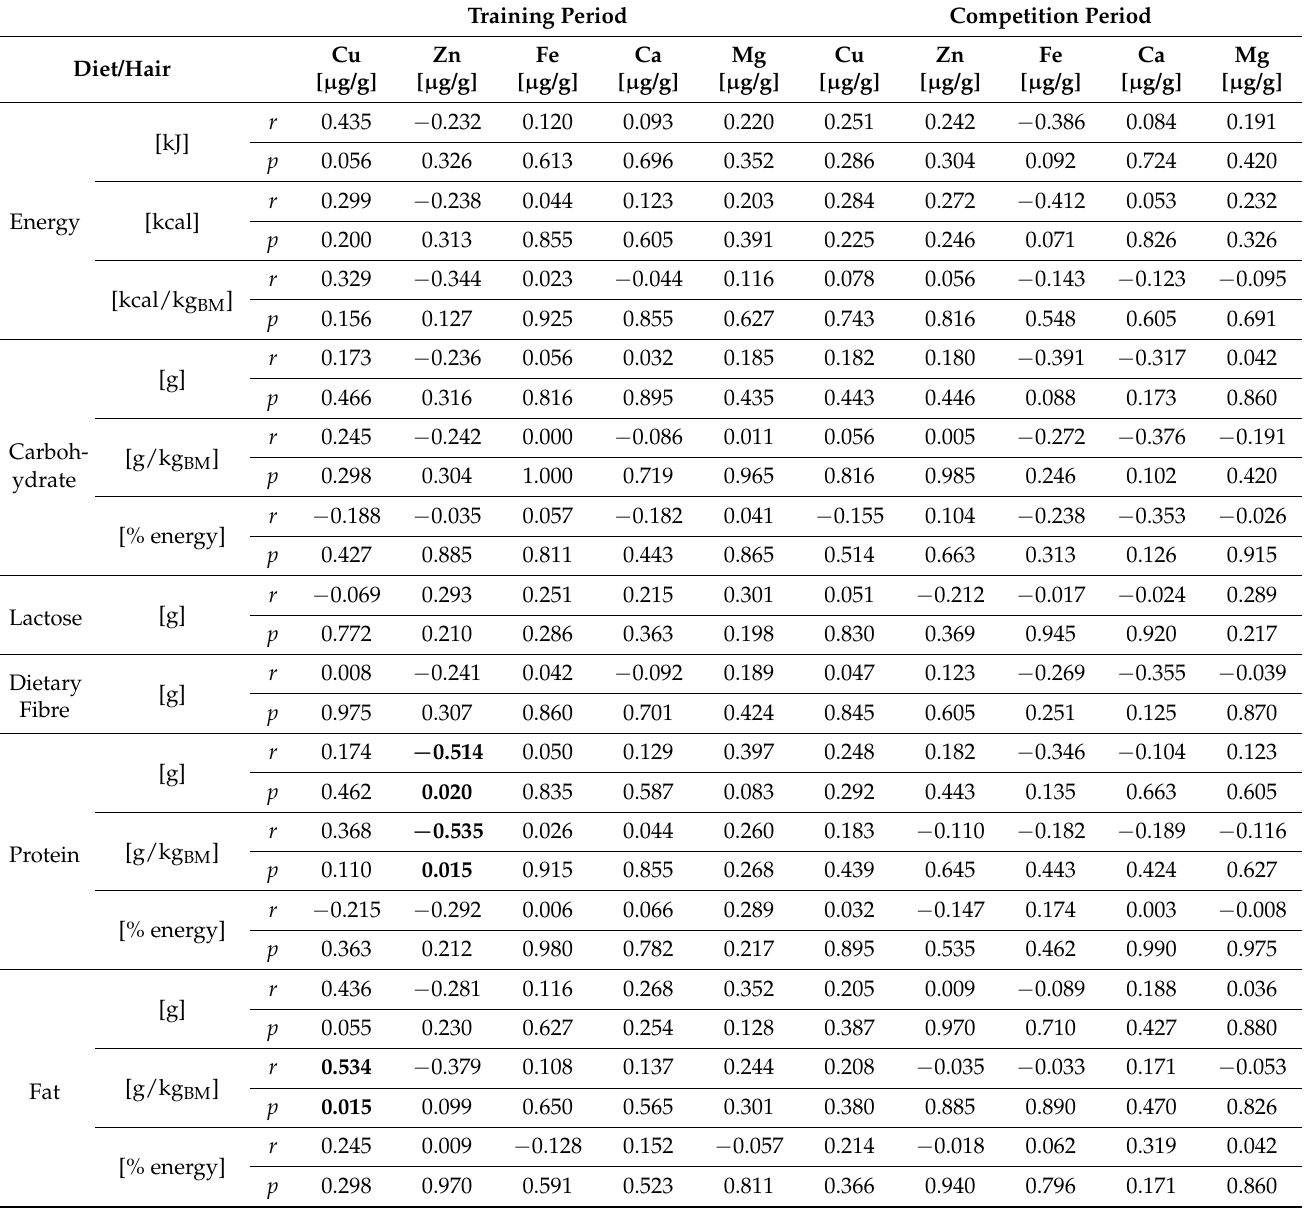
Table 6. Spearman correlation coefficient between hair mineral content and intake of macronutrients in the usual diet of